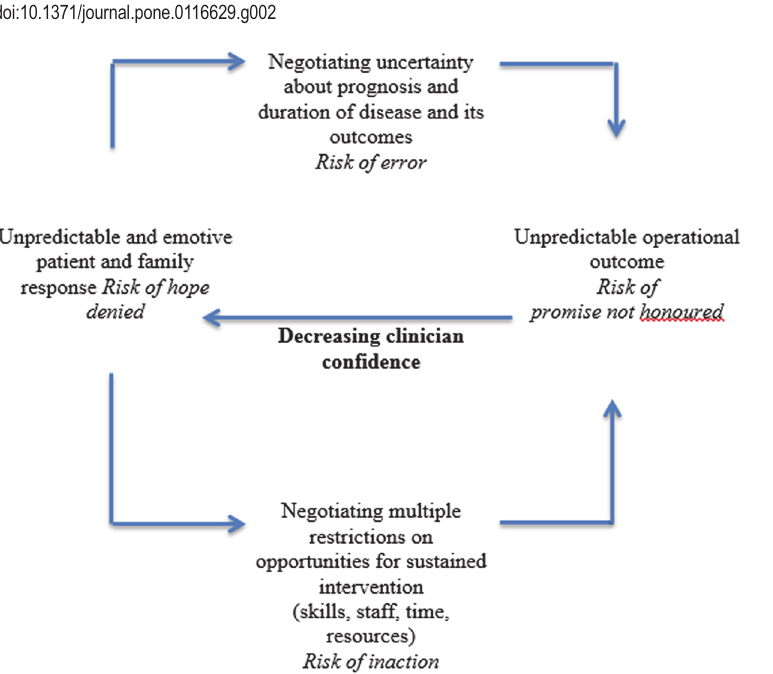
Fig 3. Operationalizing Advance Care Plans: